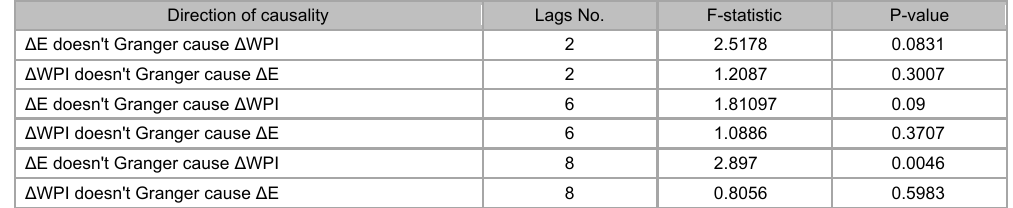
Results of Granger-causality test between exchange rate and WPI inflation Direction of causality Lags